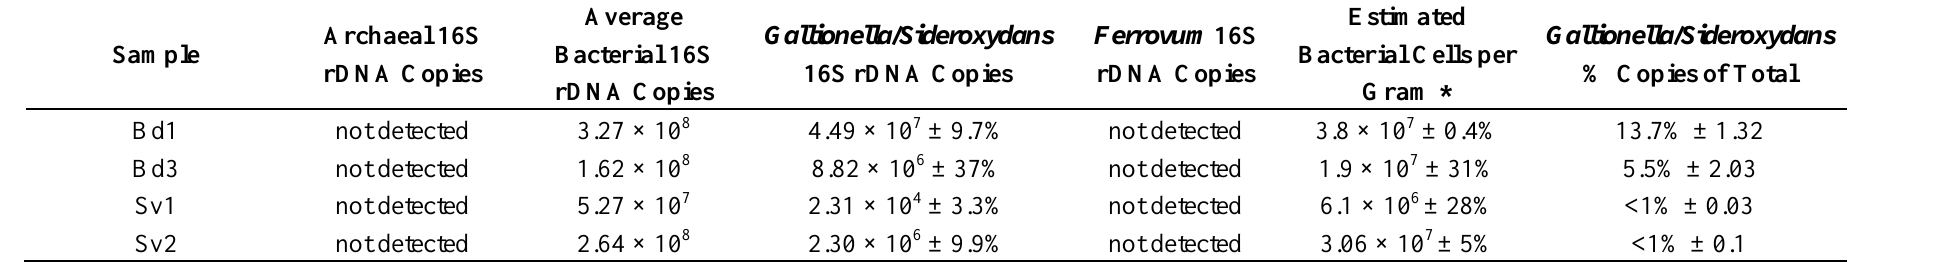
Table A2. Enumeration of Bacteria, Archaea, and the iron oxidizers Gallionella / Sideroxydans and Ferrovum 16S rDNA copies for the AMD samples collected at Bjørndalen and Sverdrup using qPCR. Copy numbers are given per gram of sample material (wet weight). Total bacterial cell numbers were calculated assuming an average number of 4.3 copies per cell. For Gallionella / Sideroxydans , cells per gram were divided for one as the genome sequences deposited contain an average of one